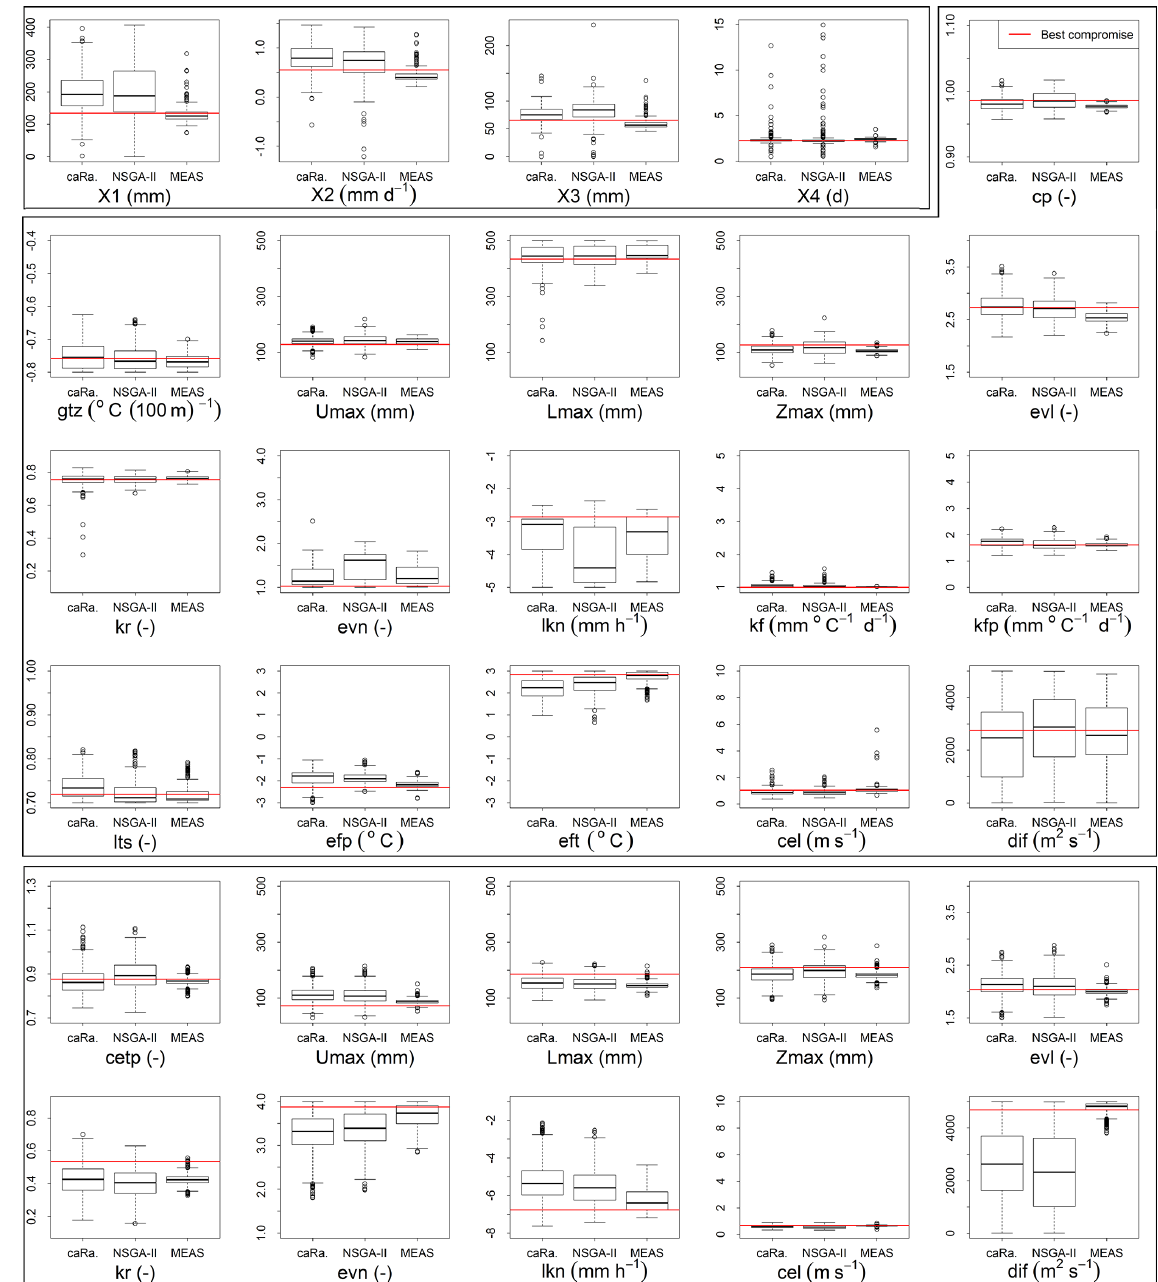
Figure 10. Calibrated parameter distributions for the sets on the Pareto front ( y limits are the calibration bounds, except for X 1 to X 4) with caRamel, NSGA-II and MEAS for the three hydrological case studies: Blue River (first block of four parameters), Durance River (second block of 16 parameters) and Tarn River (third block of 10 parameters). Parameter values from the “best compromise” set are displayed in